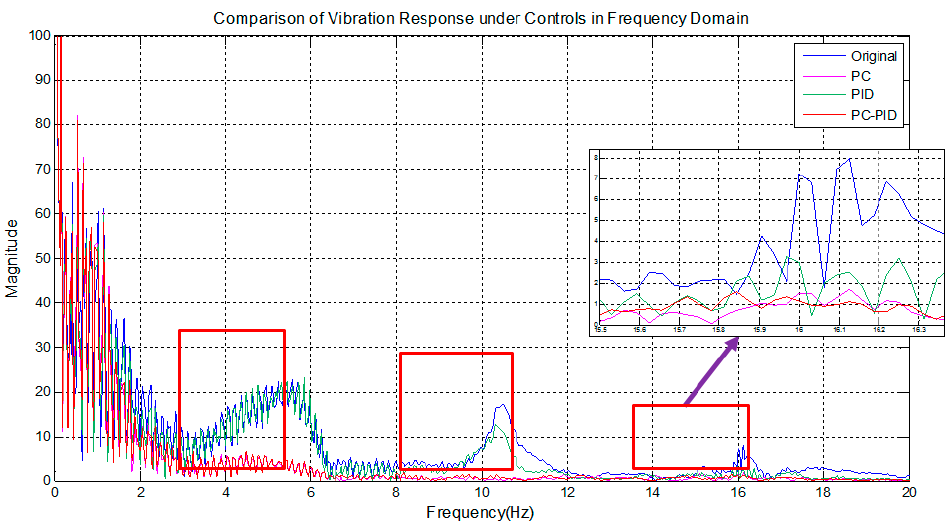
Figure 10. Half-shaft torque comparison with di ff erent control methods in frequency domain. Table 2. Comparison of the vibration deduction of di ff erent control methods in the frequency